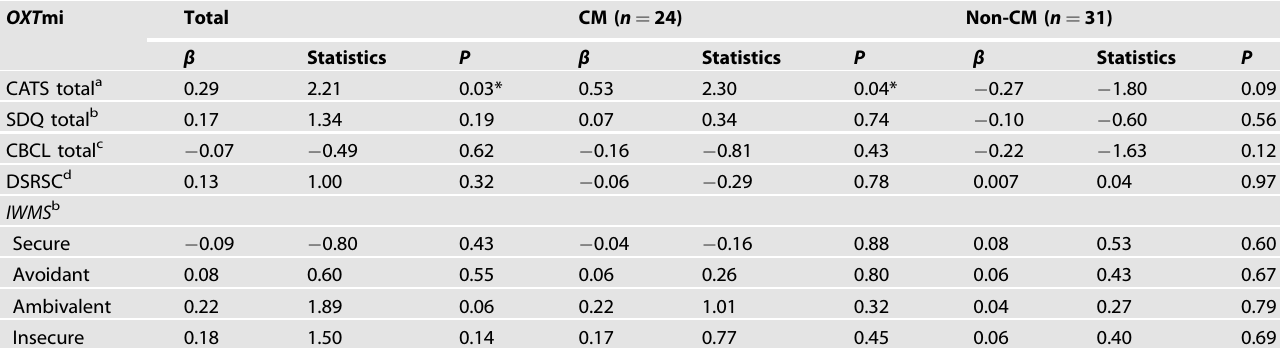
Fig. 3 Results of the multiple regression analysis between OXT mi and the regional function for monetary reward task. Brain region showing negative correlations between the degree of OXT mi and activation in the right putamen ( x = 26, y = 16, z = − 4, T = 4.26, cluster size = 165 voxels) after correcting for age, sex, and FSIQ as determined by multiple regression analysis. The statistical threshold for the contrasts was voxel-level P < 0.001 uncorrected for height, corrected to P < 0.05 using the cluster size. The color bar represents the T -statistic range. Table 1. Multiple linear regression results of OXT mi for the association with the clinical